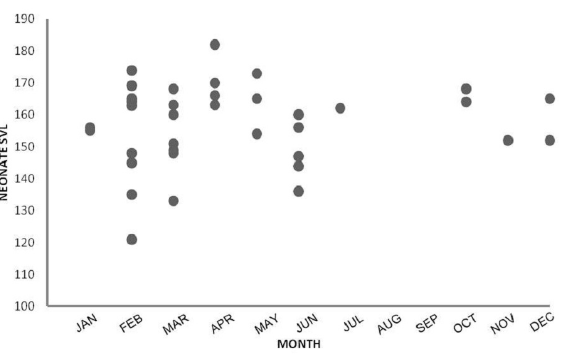
Figure 4 - Size distribution (SVl, in mm) of neonates of Erythrolamprus miliaris from the state of Rio de Janeiro throughout the year; mean values were used in cases when there were two or more neonates from a single